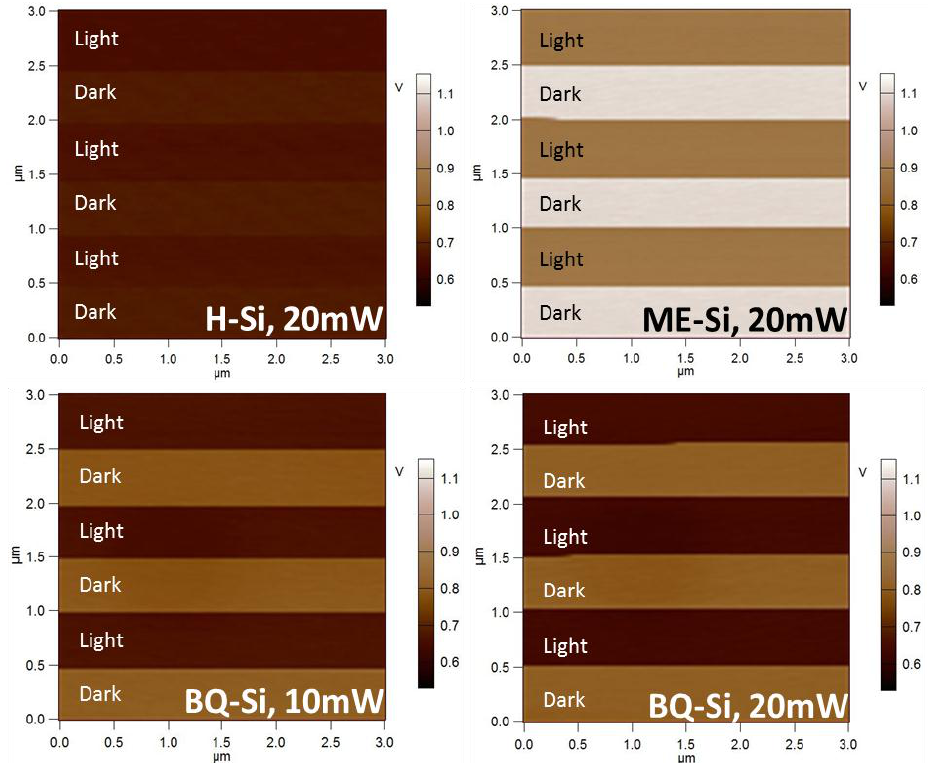
Figure 5. The contact potential difference (CPD) map of n-type silicon wafers under three surface treatments: H-Si, BQ-Si, and ME-Si. The Kelvin probe scan size was 3.0 µm × 3.0 µm. Tip potential was −217 mV with respect to an HOPG reference. Surface contact potential of all samples shift when the 650 nm laser (10 mW or 20 mW) was switched on and off during the scan.